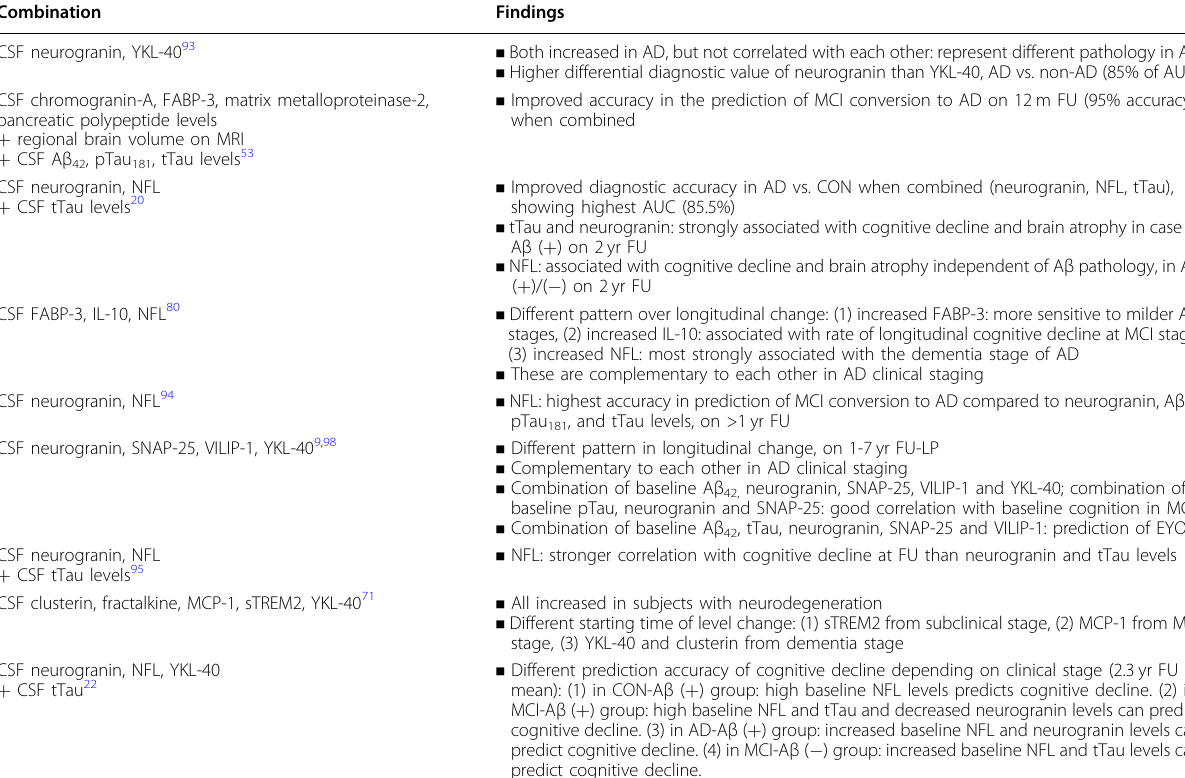
Table 2 Sets of new biomarker combinations. Combination